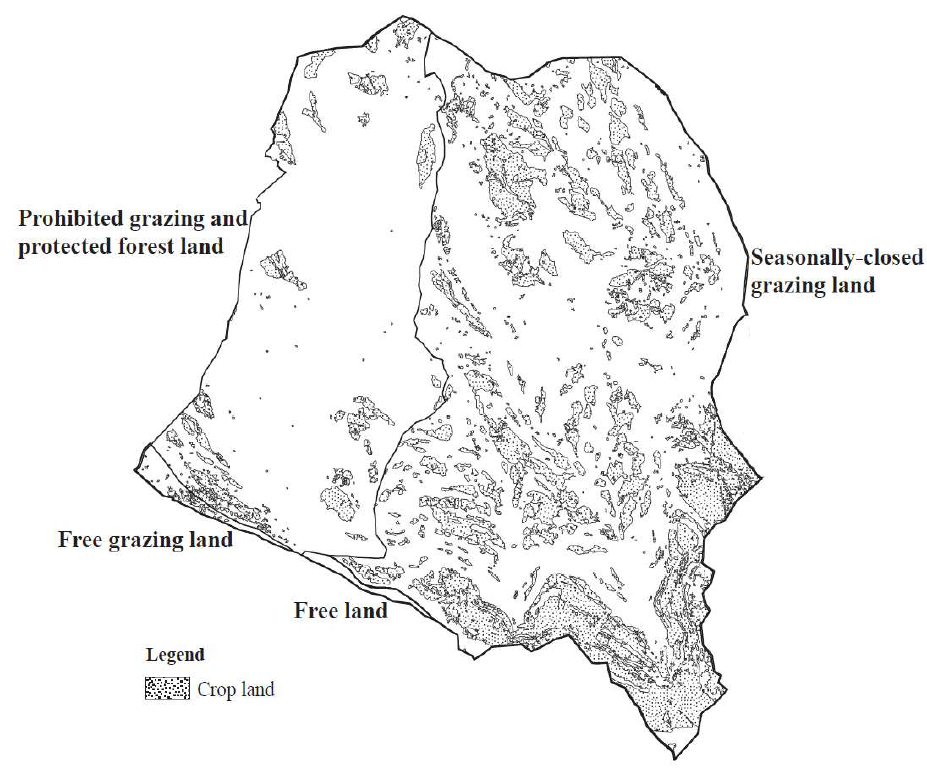
Figure 4. Spatial distribution of croplands in Adi Zaboy watershed. Table 2. Spatial distribution of croplands by the land management and slope in Adi Zaboy watershed.